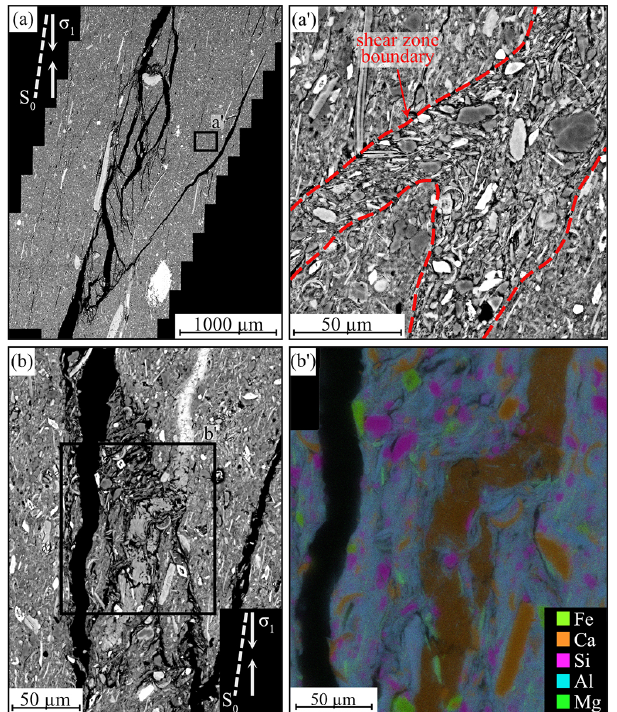
Figure 8. SEM-BSE images presenting deformation structures of the samples tested at 16MPa effective confinement. Panel (a) shows the rotating fabric in the transition zone, which aligns to the shear zone. Panel (b) presents typical grain-scale deformation markers such as intracrystalline rotational sliding, and stretching of fossil shells. Larger, elongated calcite grains hosts intragranular flexu- ral fractures. Panel (c) displays inter and intracrystalline sliding of phyllosilicates and strained fossil shells leaving crushed trails aligned parallel to the shear zone